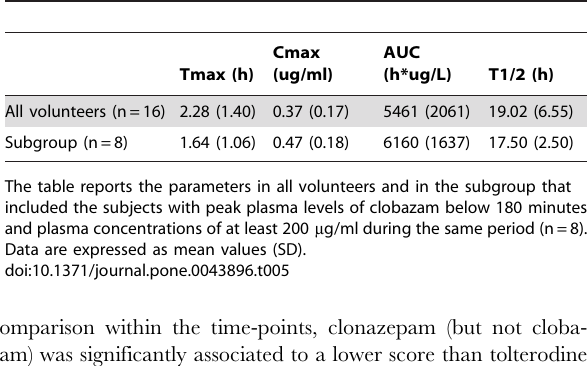
Table 5. Pharmacokinetic parameters of clobazam.